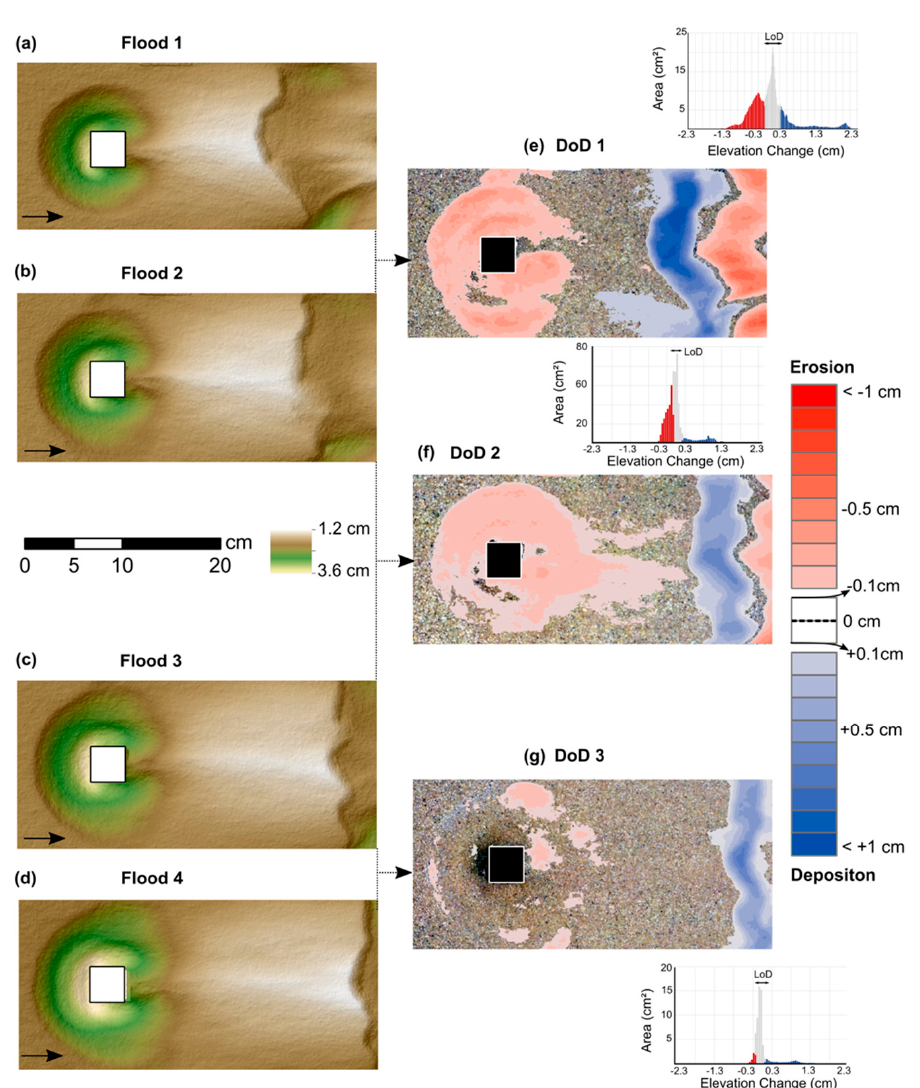
Figure 19. Modeled DEMs ( a – d ) and associated DoDs ( e – g ) for flash flood hydrographs in clear-water conditions: ( a ) Flood 1, ( b ) Flood 2, ( c ) Flood 3, ( d ) Flood 4, ( e ) DoD 1, ( f ) DoD 2, and ( g ) DoD 3. Arrows indicate direction of flow.